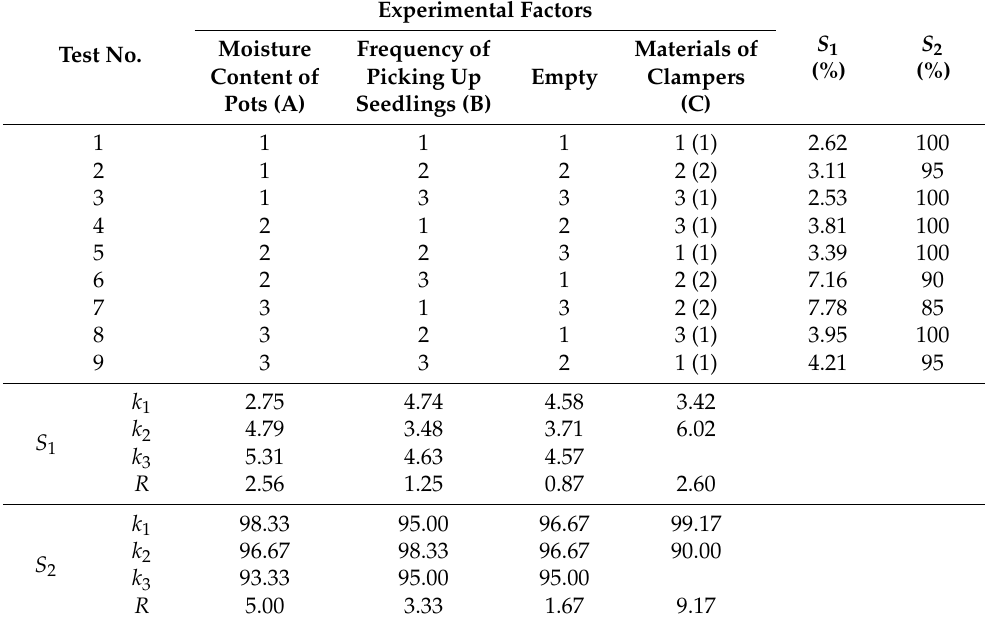
Table 6. Experiment scheme and results.